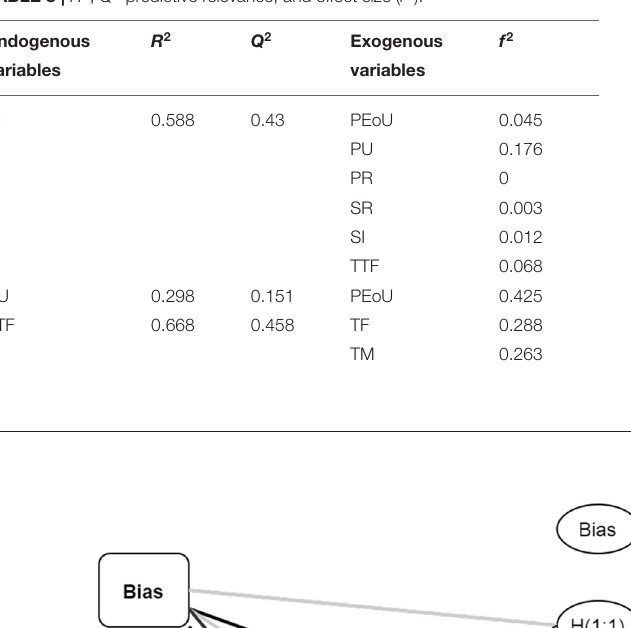
TABLE 8 | R 2 , Q 2 predictive relevance, and effect size ( f 2 ).